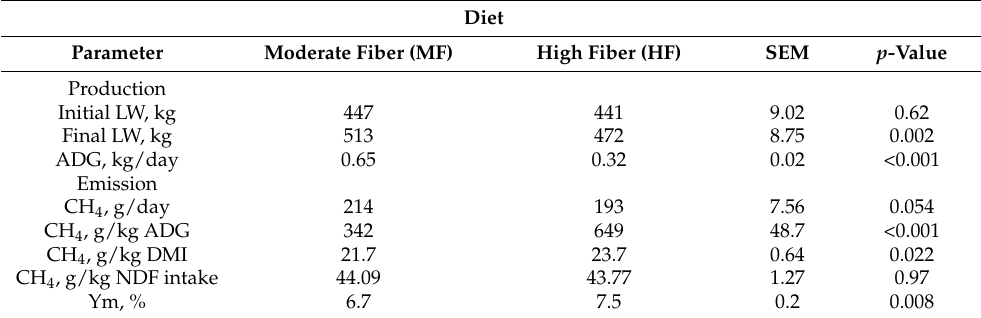
Table 4. Productive and methane emission variables of steers fed forage diets with moderate fiber content (MF) and higher fiber content